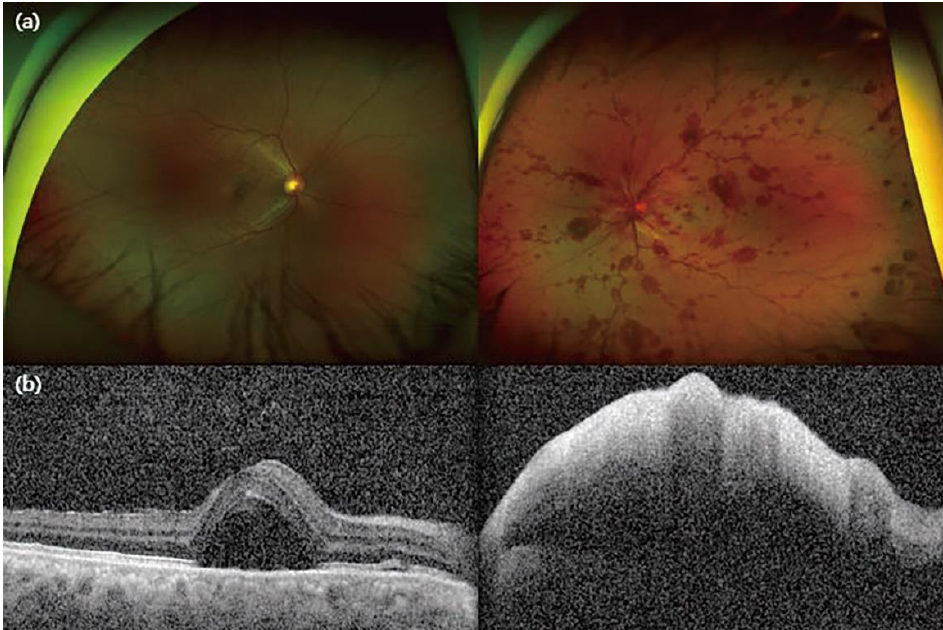
Figure 1. At the initial symptom presentation ( a ) funduscopy showed sudden-onset central retinal artery occlusion (CRAO) with central retinal vein occlusion (CRVO) in the left eye. ( b ) Optical coherence tomography (OCT) showed subretinal fluid (SRF) in the right eye and diffuse thickening and hyper-reflectivity of neurosensory retinal layers with marked posterior shadowing in the left eye.